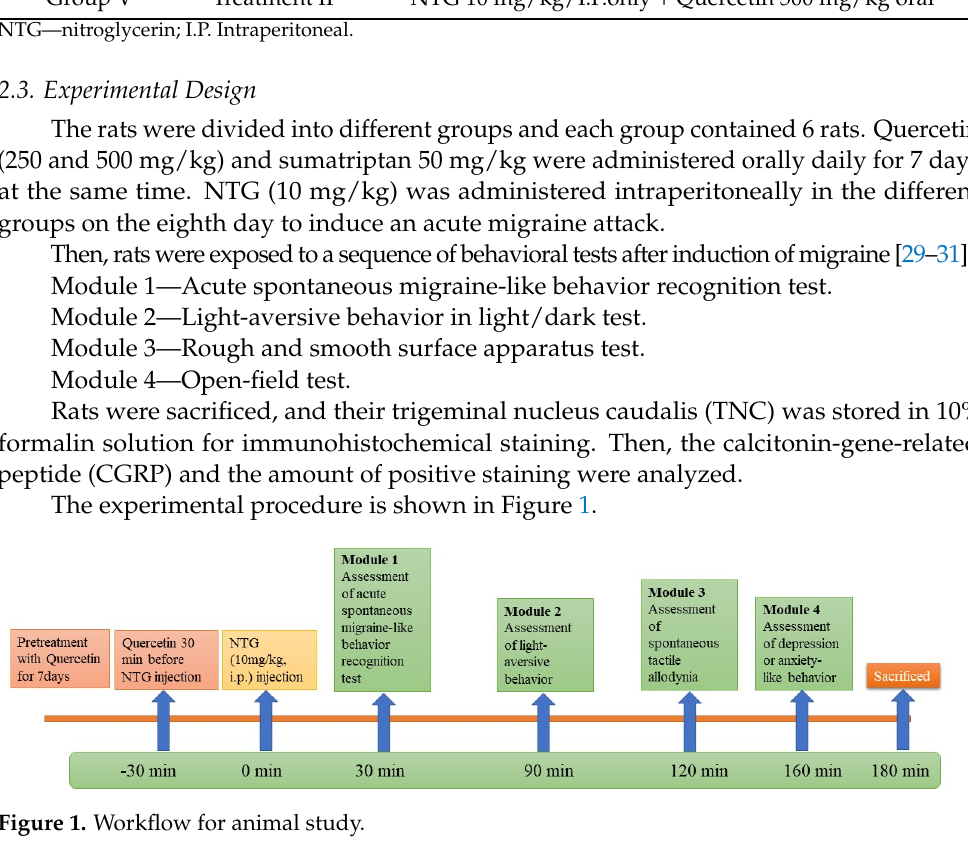
Table 1. Grouping of animals.